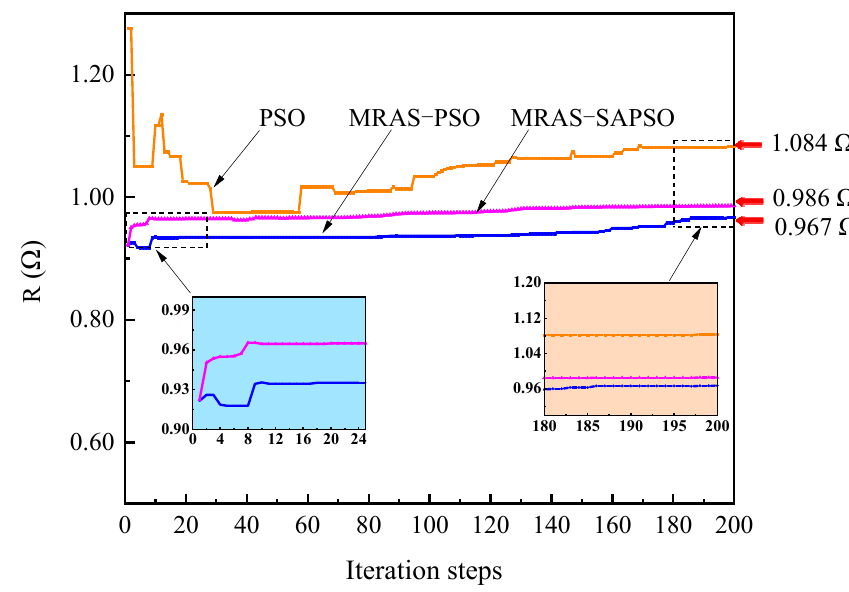
Figure 4. Resistance identification curve.